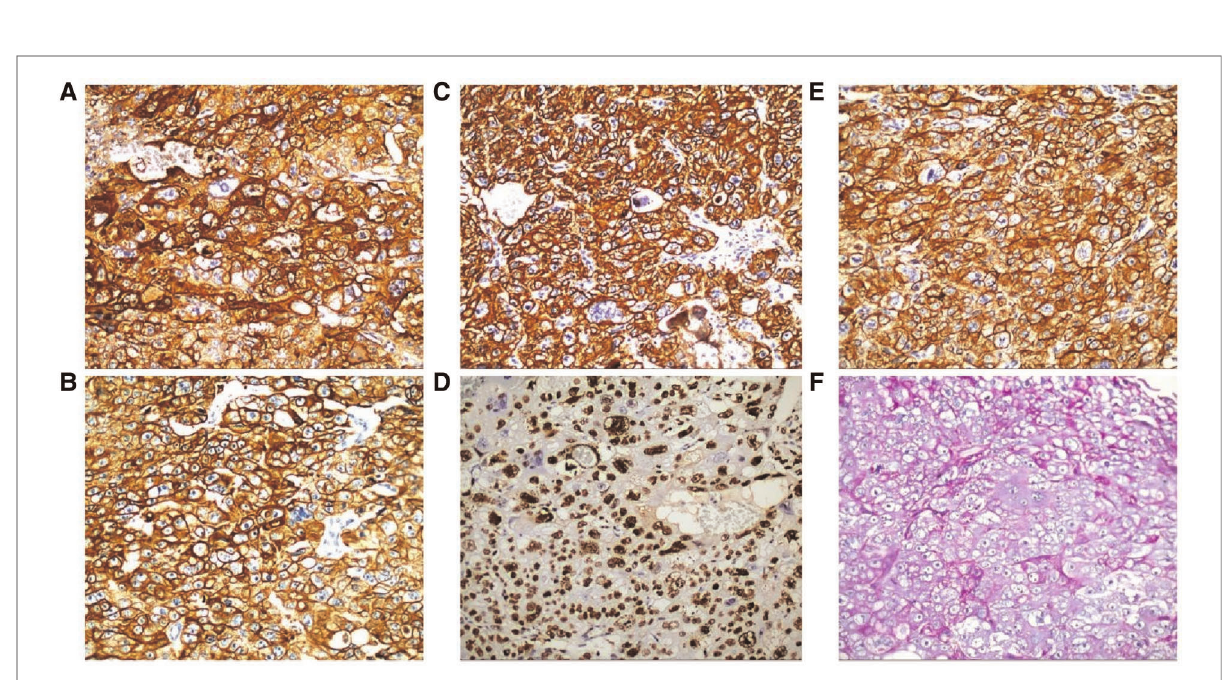
FIGURE 5 Immunohistochemistry: CD10 (+) ( A ), ck8/18 (+) ( B ), CK19 (+) ( C ), CKP (+) ( D ) and Ki-67 labelling index of 60% (+) ( E ) (HE ×200). Histochemical staining: PAS (+) ( F ) (SP